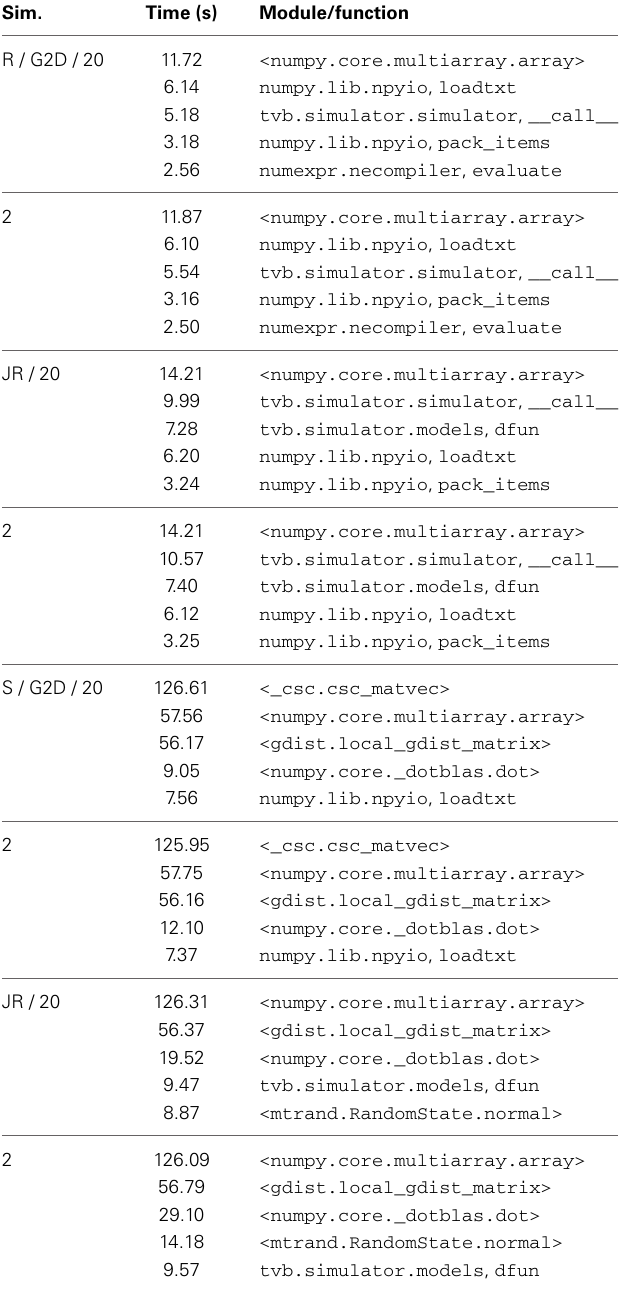
Table 2 | Profiling results for several simulation types, “R” for region level simulations, “S” for surface